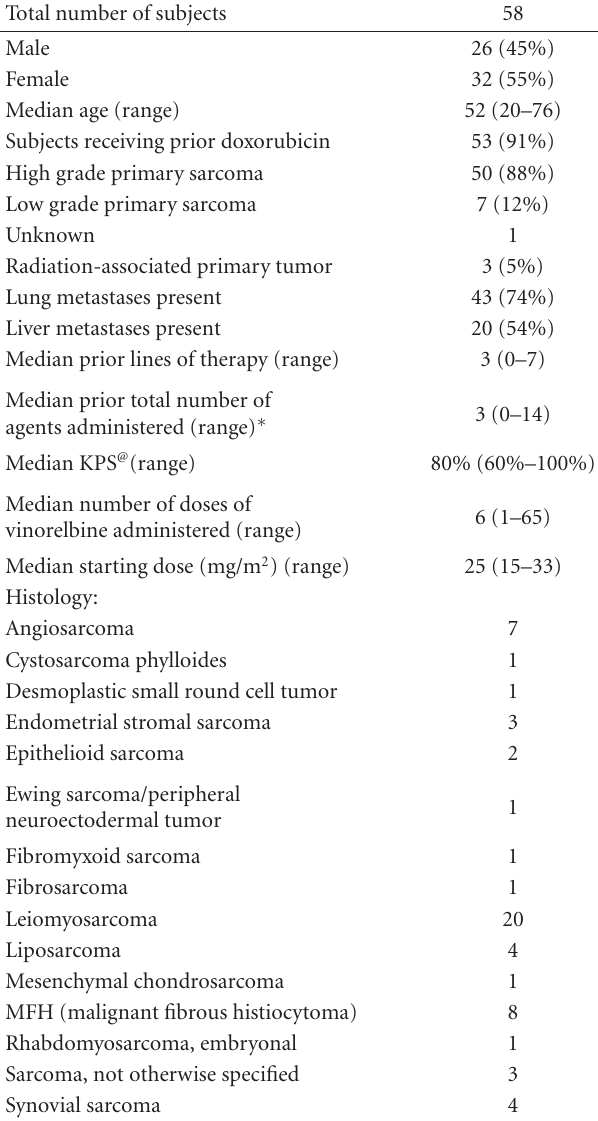
Table 1: Patient